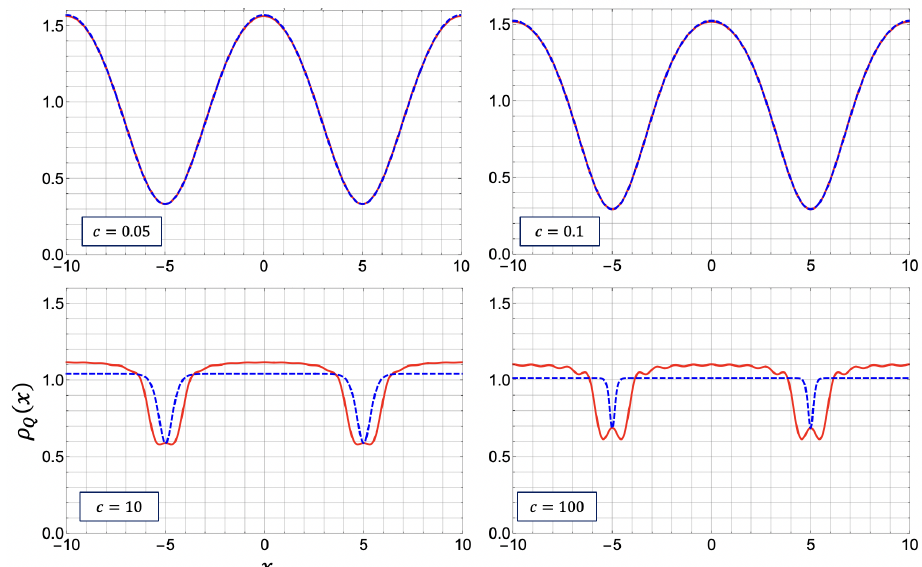
Figure 8. Configurations of the Bethe quantum numbers. ( i ) Configuration I + , which is obtained by adding two particles (yellow circles) to the ground state (red circles). ( ii ) Two holes, which correspond to a subset p = { p 1 , p 2 } of I + , are punched in the Bethe quantum numbers I + with the value of P defined in (87).